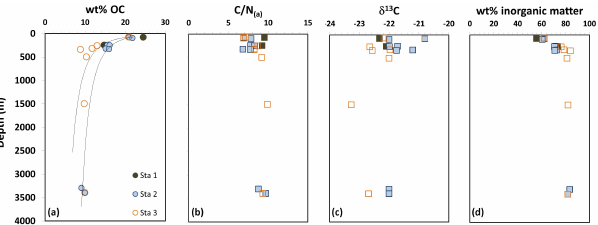
Figure 3. Weight percent organic carbon (a) , atomic ratios of or- ganic carbon to total nitrogen (b) , the stable carbon isotopic compo- sition of the bulk organic matter (c) and the percentage of inorganic material (d) . Power functions in the left-most panel were added to aid the eye in discerning possible differences between the three sta- tions. Samples from deeper than 500m were collected via slow net haul (see Methods section).